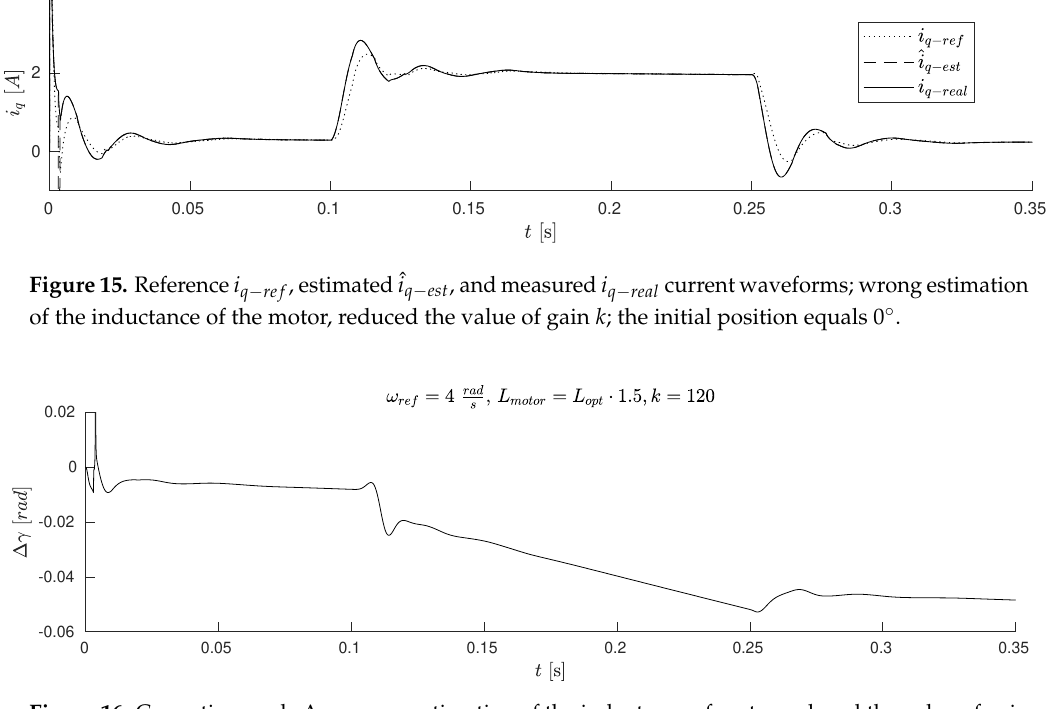
Figure 16. Correction angle ∆ γ ; wrong estimation of the inductance of motor reduced the value of gain k ; the initial position equals 0 ◦